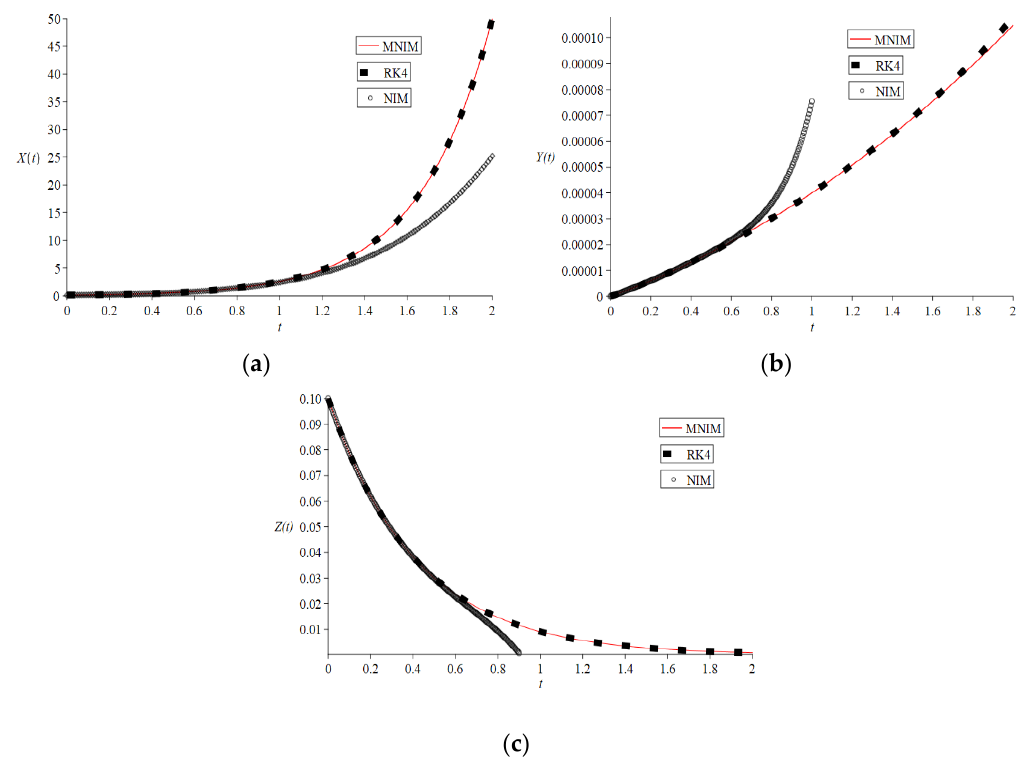
Figure 1. Graphical Comparison between the results of 2-Iterations MNIM, 5-Iterations NIM and RK4 method for ( a ) X ( t ) , ( b ) Y ( t ) , ( c ) Z ( t ) of HIV Infection